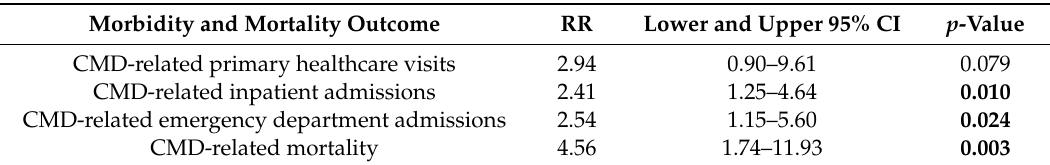
Table 2. Relative risk of cardiometabolic disease (CMD)-related mortality and morbidity, low versus high cumulative exposure score (CES). RR—relative risk; CI—confidence